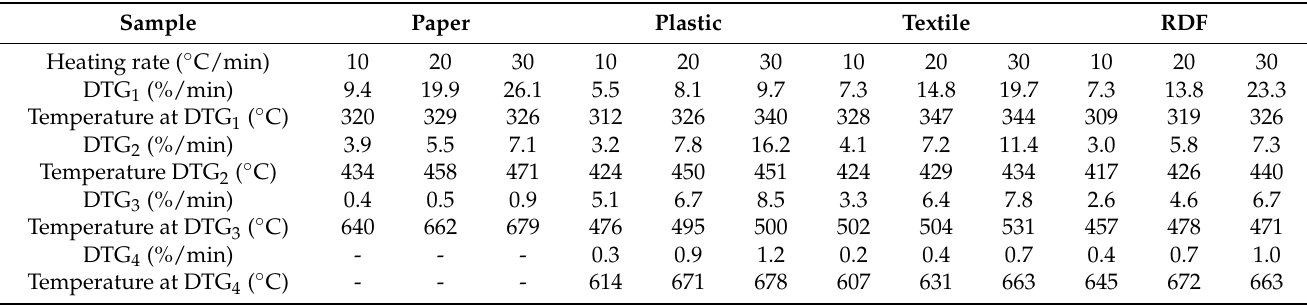
Table 3. Differential thermogravimetry (DTG) peak characteristics of paper, plastic, textile, and RDF samples during combustion.